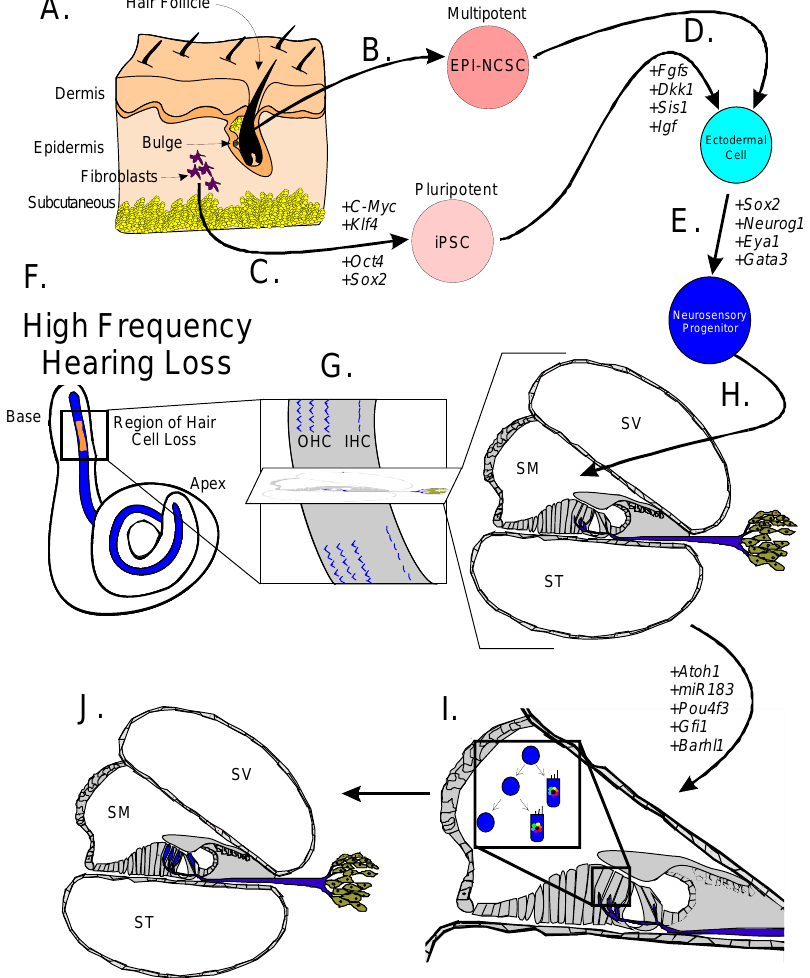
Figure 3. Multipotent stem cells (EPI-NCSCs) and pluripotent stem cells (iPSCs) can be derived from donor skin (A). EPI-NCSCs from the bulge region of the hair follicle (B) and iPSCs formed from fibroblasts using C - Myc , Klf4 , Oct4 , and Sox2 (C) can be subsequently restricted in their cell fate to first an ectodermal cell (D) and then a neurosensory progenitor cell (E). The Fgfs , Dkk1 , Sis1 and Igf are among the transcription factors experimentally shown to be important to ectodermal fate [39]. Sox2 , Neurog1 , Eya1 and Gata3 are important in defining a neurosensory cell. These neurosensory cells are primed to become neurons, hair cells, or supporting cells. Patients with high frequency hearing loss have damaged neurosensory epithelia near the base of the cochlea (F) which often results in the loss of hair cells, marked by a flat organ of Corti (G). In patients with short-term hearing loss, sensory neurons survive (blue) and replacement of hair cells alone may be sufficient treatment. Patients with long-term hearing loss will have a dedifferentiated organ of Corti and a loss of sensory neurons making regeneration of the entire organ of Corti the only solution. Transplantation of either stem cells or neurosensory progenitors into the scala media (H) with subsequent targeting to damaged tissue along with upregulation of hair cell specific genes may enable hair cell regeneration (I). Hair cell fate will be defined and subsequently stabilized through expression of Atoh1 , miR183, Barhl1 , Pou4f3 and Gfi1